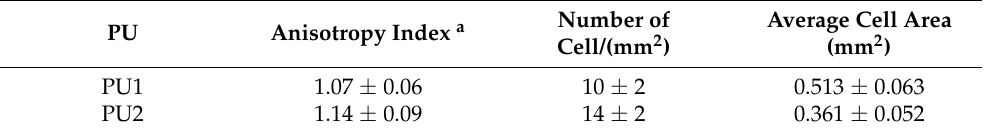
Table 1. Main physical properties of the polyether polyurethane foams PU1 and PU2.